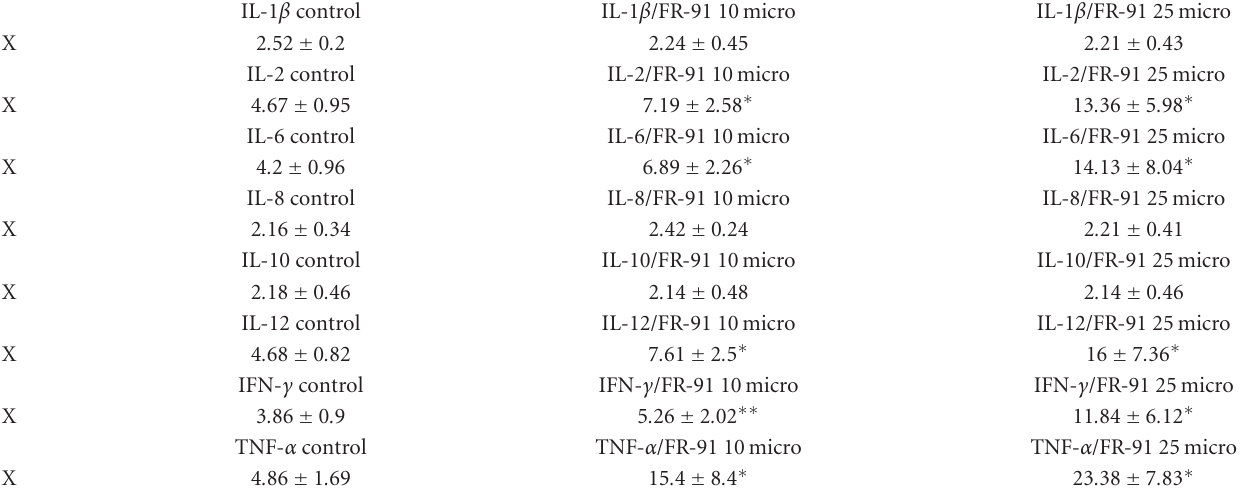
Table 4: E ff ect of FR-91 on production of cytokines by peripheral blood mononuclear cells from NHL